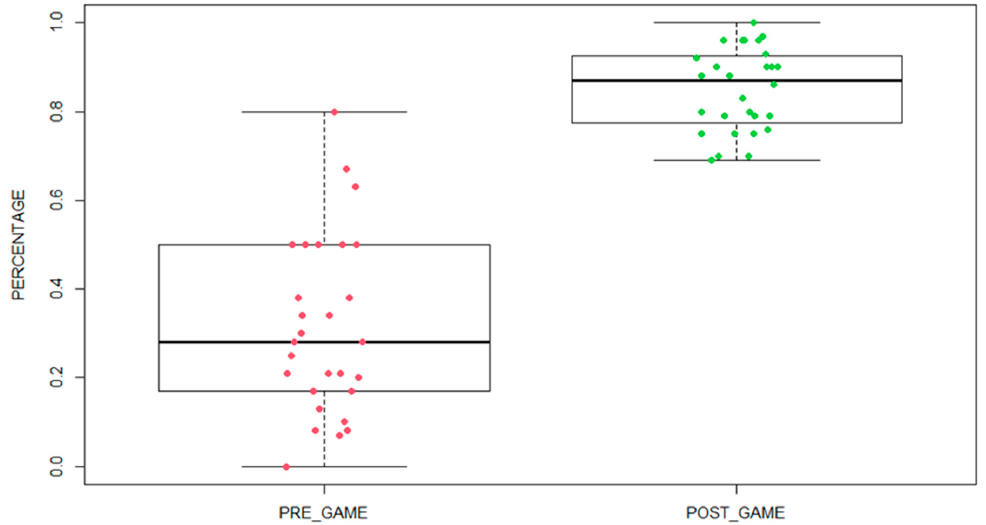
Figure 13. Difference between the percentage of correct responses in pre-game and post-game in total students.